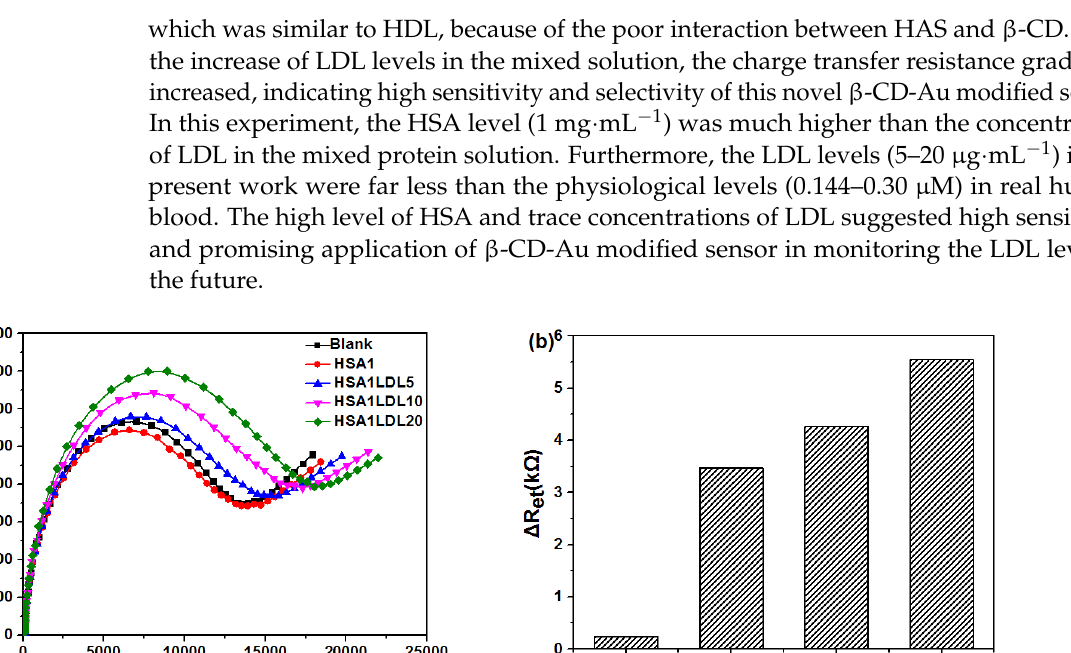
Figure 7. ( a ) Nyquist diagram of faradaic impedance spectra and ( b ) ∆ Ret of binary proteins for β -CD based sensor incubating in HSA/LDL binary proteins in PBS (50 mM, pH 7.0) solution containing 0.1 M KCl and 5 mM K 3 [Fe(CN) 6 ]/K 4 [Fe(CN) 6 ].